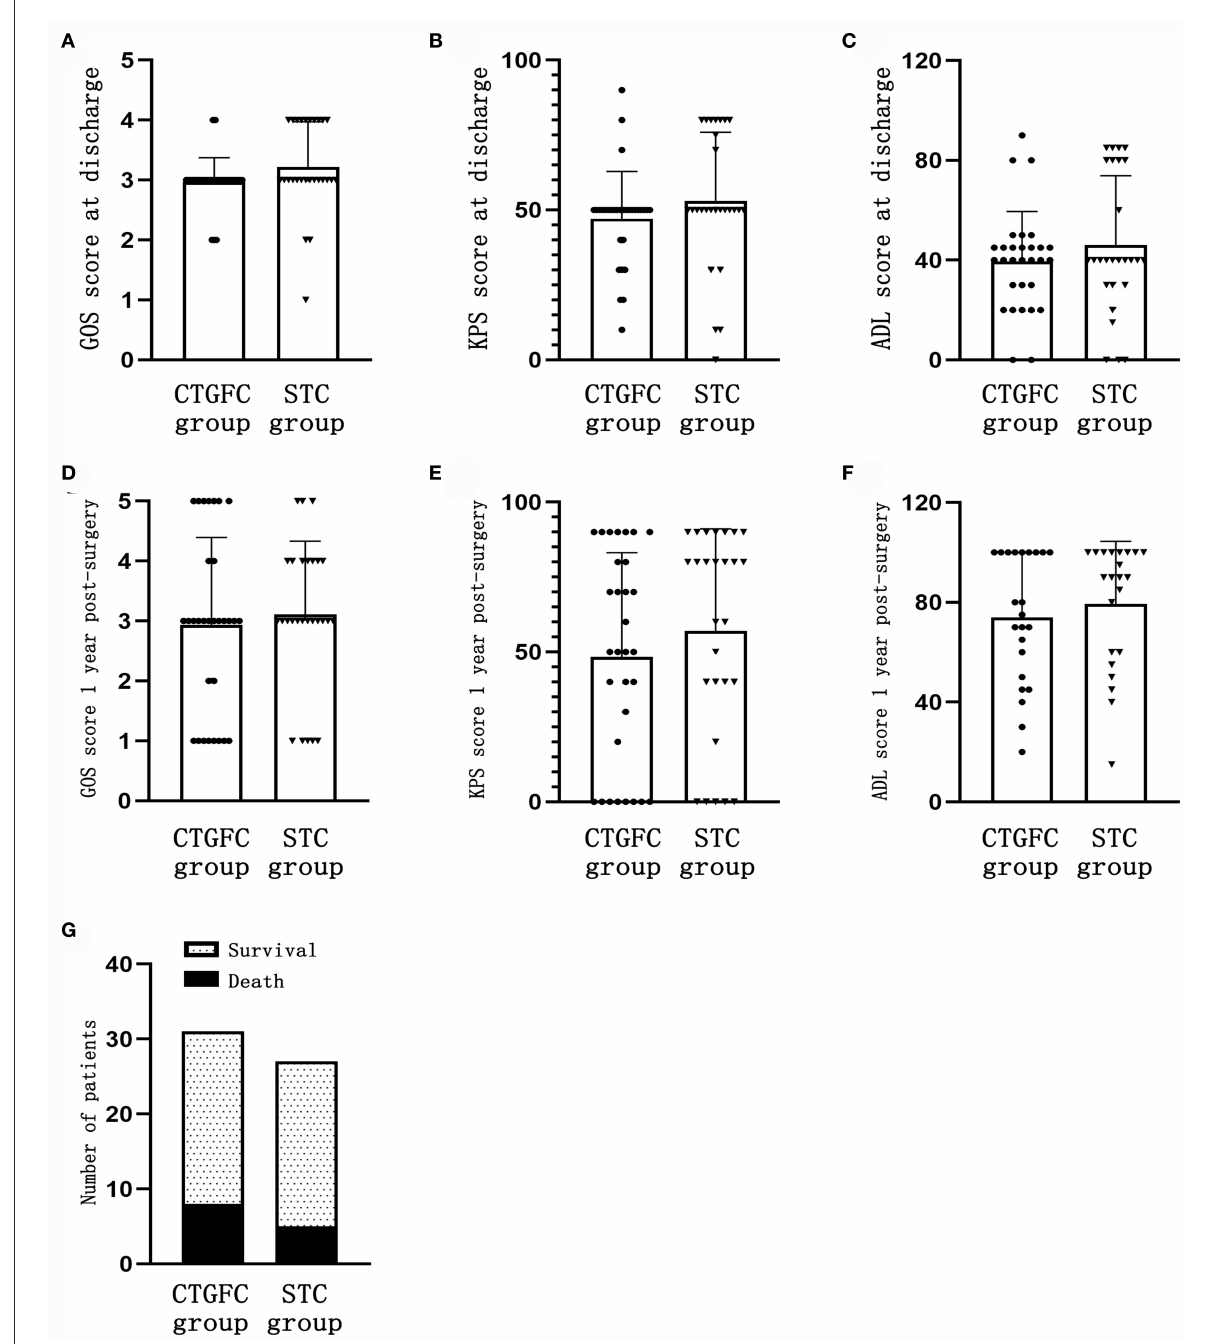
FIGURE5 Short-time and long-term functional outcomes. (A) GOS score at discharge. (B) KPS score at discharge. (C) ADL score at discharge. (D) GOS score 1 year after the operation. (E) KPS score 1 year after the operation. (F) ADL score 1 year after the operation. (G) Mortality rate 1 year after the operation. CTGFC, CT image-guided free-hand catheter technique; STC, stereotactic catheter technique; GOS, Glasgow outcome scale; KPS, Karnofsky performance score; ADL, activities of daily living.